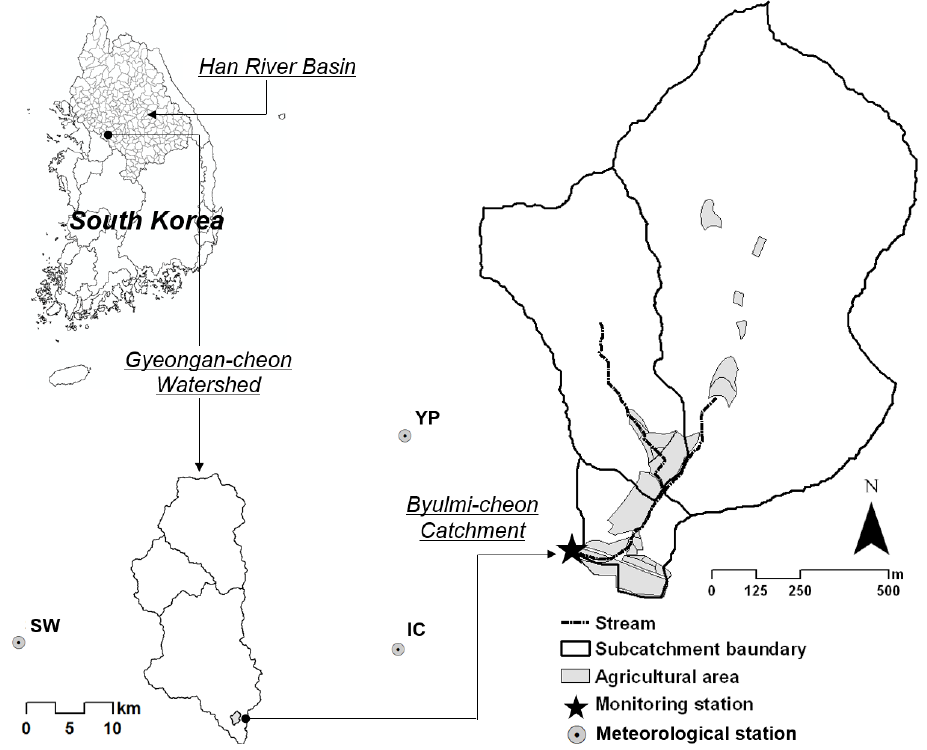
Figure 2. Location of the studied watershed, agricultural area distribution, and sub-watershed boundary for HSPF (Hydrological Simulation Program–Fortran) watershed modeling [2]. boundary for HSPF (Hydrological Simulation Program–Fortran) watershed modeling